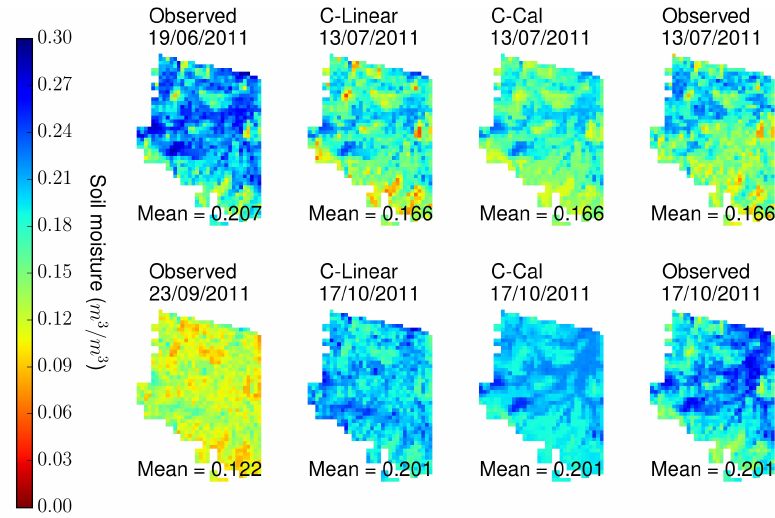
Figure 20. Comparison of the spatial distribution for the observed and MAPSM soil moisture at a spatial resolution of 500 m for the C-Cal and C-Linear experiments for two events. Observed spatial distribution on 19 June 2011 is used to retrieve the soil moisture for 13 July 2011 and 23 September 2011 is used for 17 October 2011.